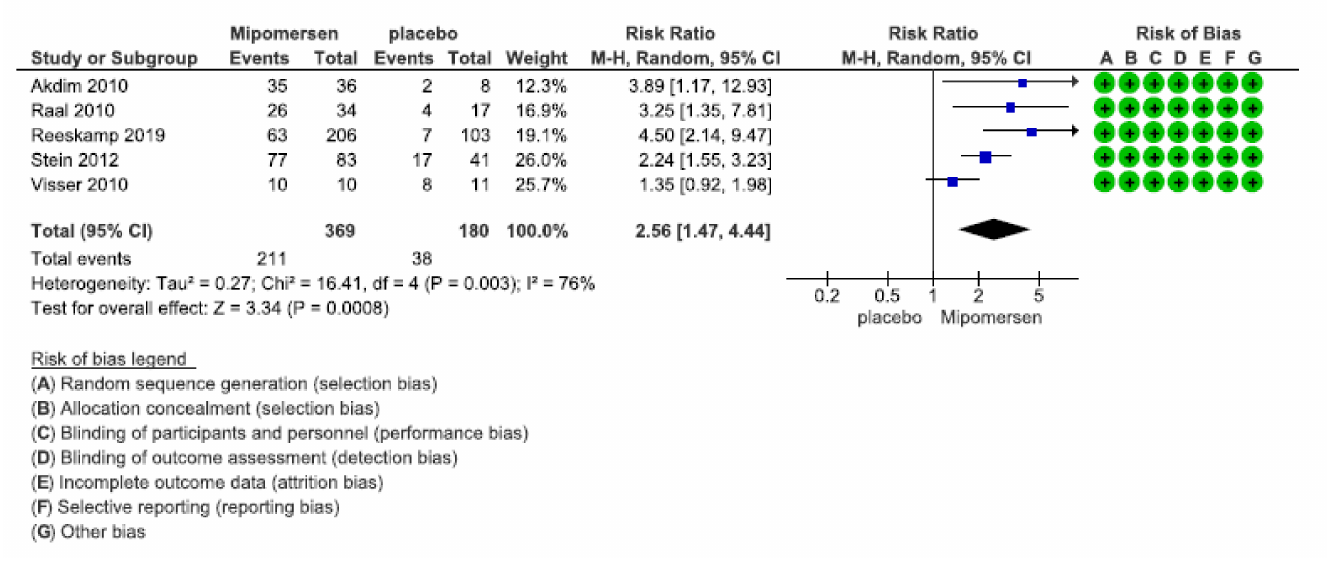
Figure 5. Forest plot for injection site